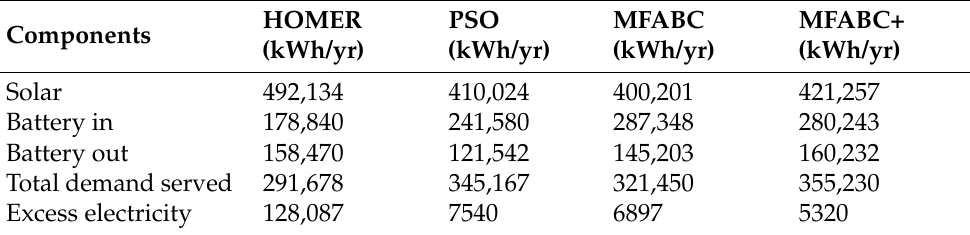
Table 5. Results obtained using all solution methods (contd.).